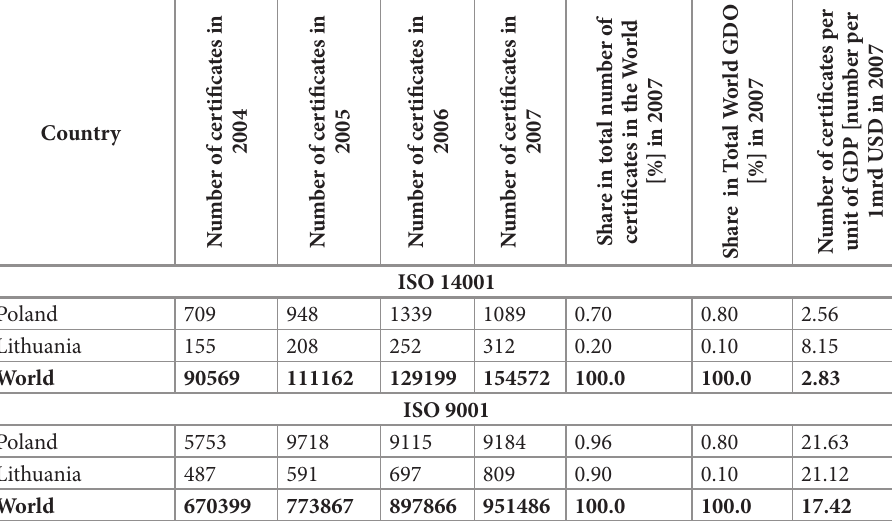
Table 3. Numbers of ISO 9001 and ISO 14001 certificates in Poland and Lithuania in relation to Gross Domestic Product (GDP)